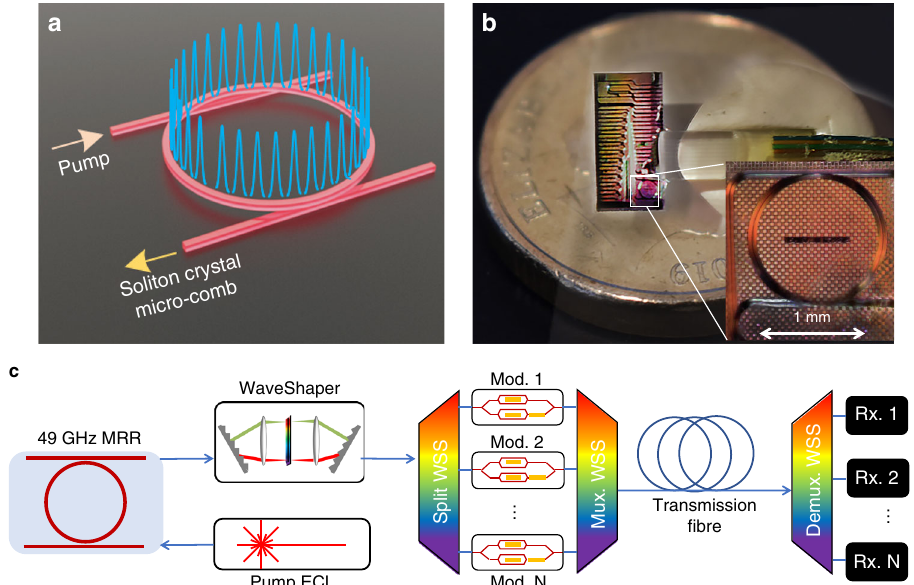
Fig. 1 Conceptual diagram of a soliton crystal micro-comb communications experiment. a . Illustration of the soliton crystal state used in this paper. We infer from the generated spectrum that the state was a single temporal defect crystal across the ring. The state had a characteristic ‘ scalloped ’ micro-comb spectrum, corresponding to the single temporal defect crystal state. b Photograph of the fi bre-optic packaged micro-ring resonator chip used for soliton crystal generation. The full chip is 5 mm × 9 mm, of which we use devices and access waveguides on ~ ¼ of the area. The AUD $2 coin (20.5 mm diameter) shown for scale is similar in size to a USD nickel or a 10 Euro cent coin. Inset is a microscope image of the ring resonator element, with a scale bar. Visible distortions are due to an overlayer of glue from the fi bre array. c Experimental setup. A CW laser, ampli fi ed to 1.8 W, pumped a 48.9 GHz FSR micro-ring resonator, producing a micro-comb from a soliton crystal oscillation state. The comb was fl attened and optically demultiplexed to allow for modulation, and the resulting data optically multiplexed before the subsequent transmission through fi bres with EDFA ampli fi cation. At the receiver, each channel was optically demultiplexed before reception. ECL edge-coupled laser, WSS wavelength-selective switch, Rx